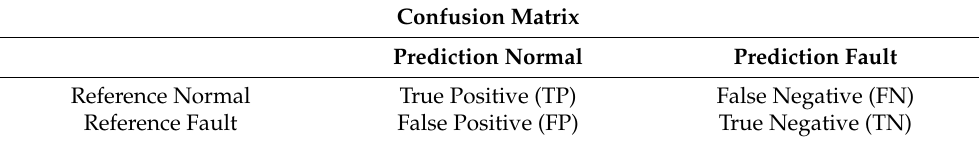
Table 3. The confusion